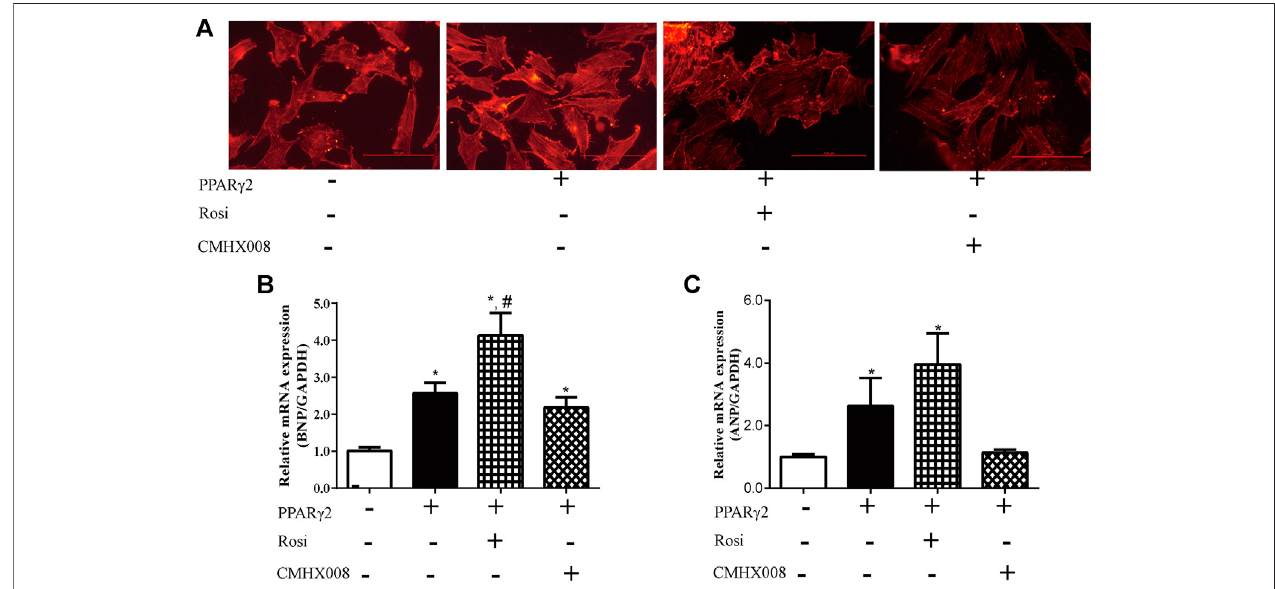
FIGURE 5 | Cardiomyocyte changes following treatment with CMHX008 and rosiglitazone in vitro . (A) Representative images of α -SMA staining with CY3 (red) in cardiomyocytes; Measurement of the mRNA levels of the hypertrophic marker genes BNP (B) and ANP (C) in cardiomyocytes. Means ± SEM, from fi ve independent experiments, * p < 0.05 vs. PPAR γ 2 ( − ); # p < 0.05 vs. PPAR γ 2 (+).